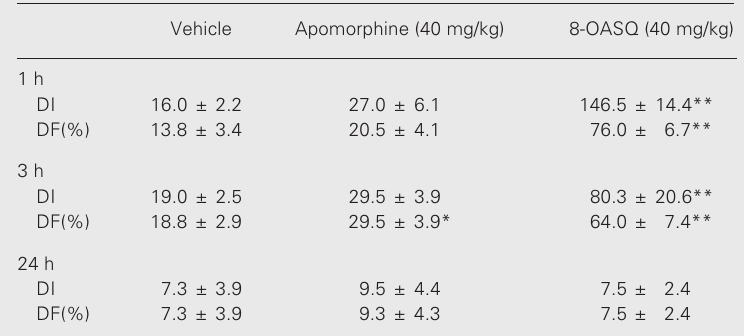
Table 2. Comet assay in brain tissue of mice treated with an intraperitoneal injection of vehicle, apomorphine, or 8-oxo-apomorphine-semiquinone (8-OASQ), and sacri- ficed 1, 3 or 24 h after